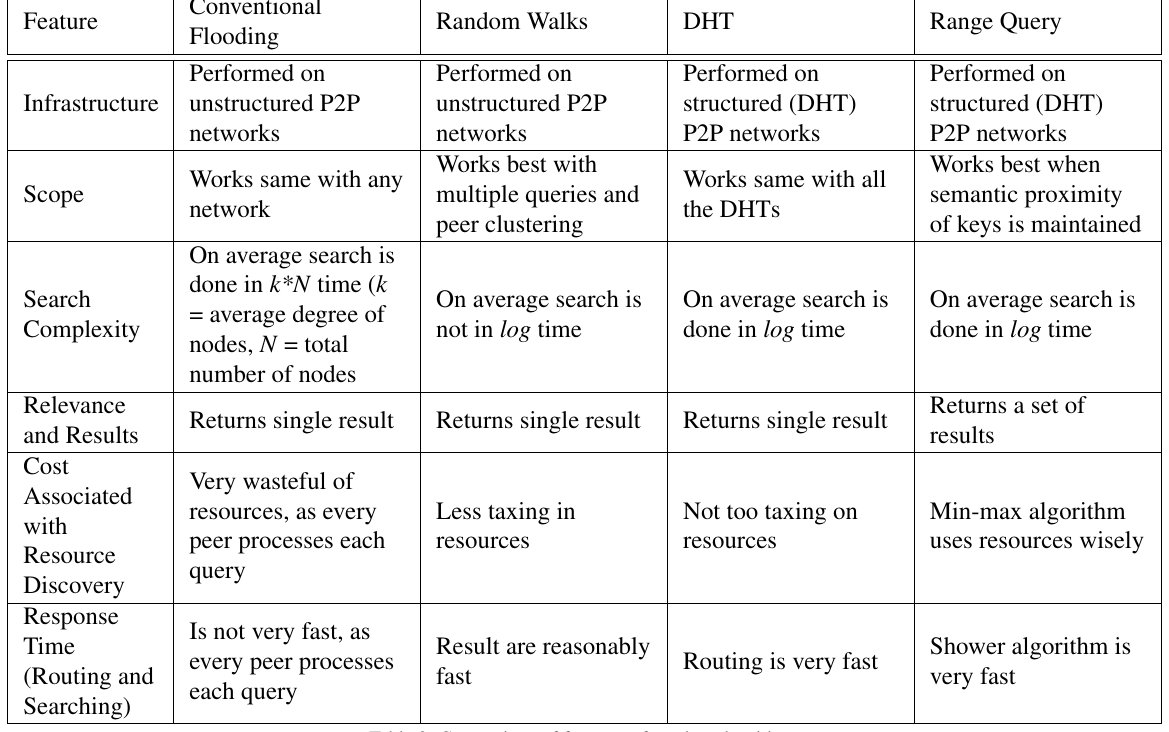
Table 3. Comparison of features of routing